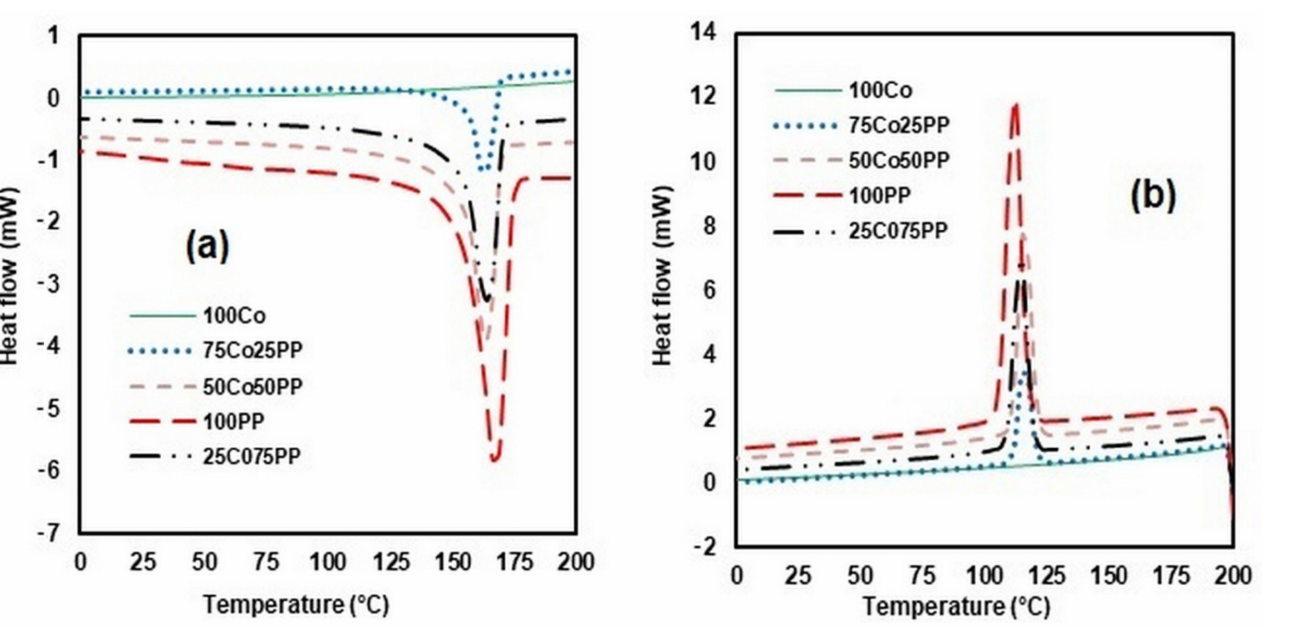
Figure 2. DSC (heating process) curves ( a ) and DSC (cooling process) curves ( b ) for coir fibres, polypropylene, and biocomposite